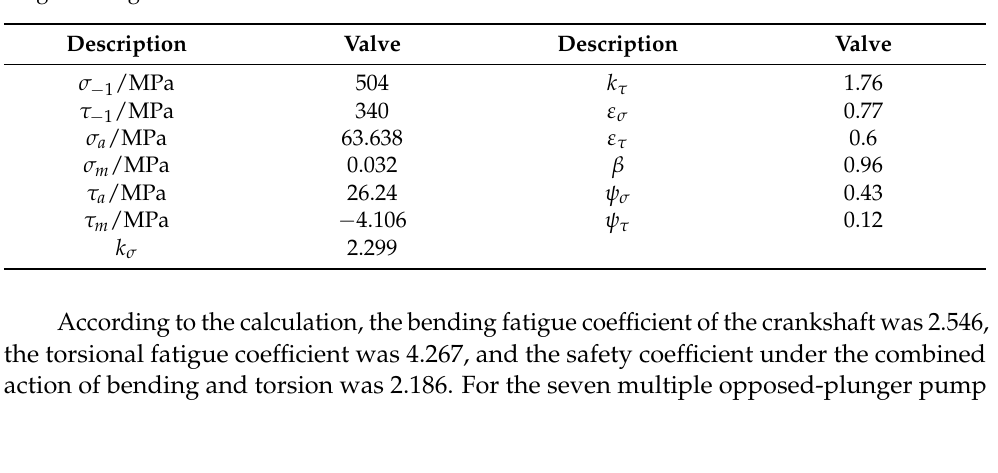
Table 3. Various coefficients in the calculation of the safety factor of 42CrMo crankshaft fatigue